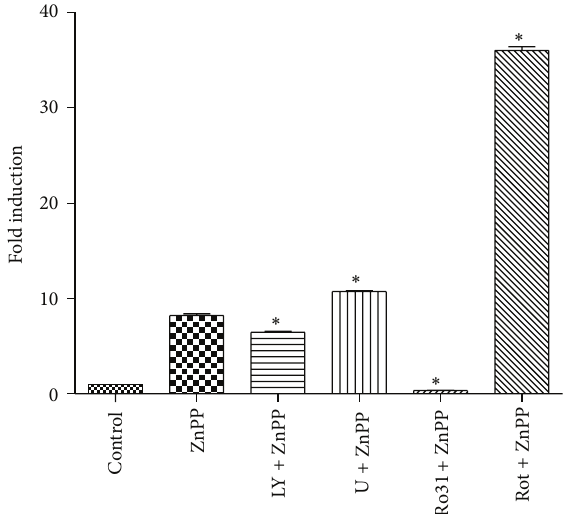
Figure 5: Real-time PCR analyses of HO-1 mRNA levels in PC-3 cells treated with ZnPP in the presence of various kinase inhibitors. PC-3 cells were pretreated with 5 𝜇 M LY294002, 10 𝜇 M U0126, 5 𝜇 M Ro 31-8220, or 2 𝜇 M rottlerin for 1h, and then treated with 10 𝜇 M ZnPP for 3 h, and relative HO-1 mRNA levels were determined by real-time PCR as described in Section 2. Results were expressed as “Fold Induction” over vehicle (DMSO-) treated control. 𝑁 = 3 ; ∗ 𝑃 < 0.05 compared with ZnPP alone.